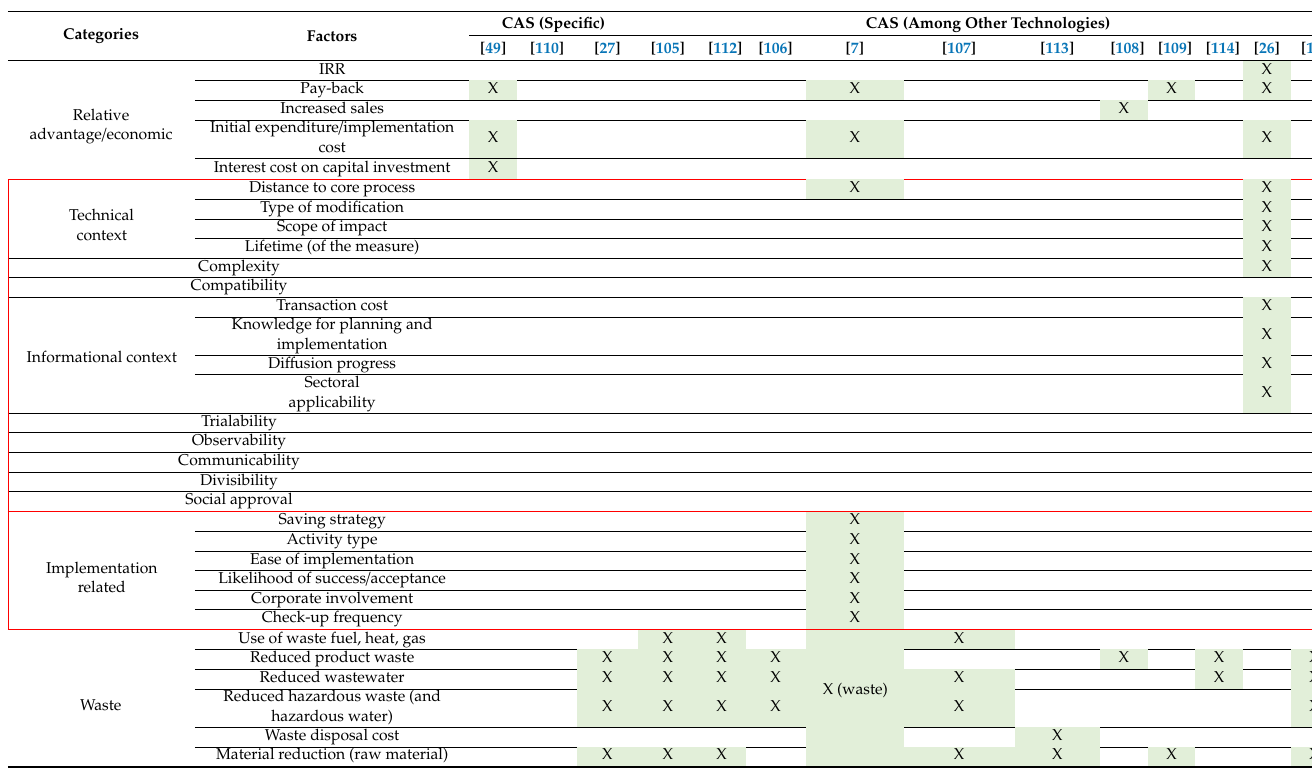
Table 2. Factors used in literature to describe